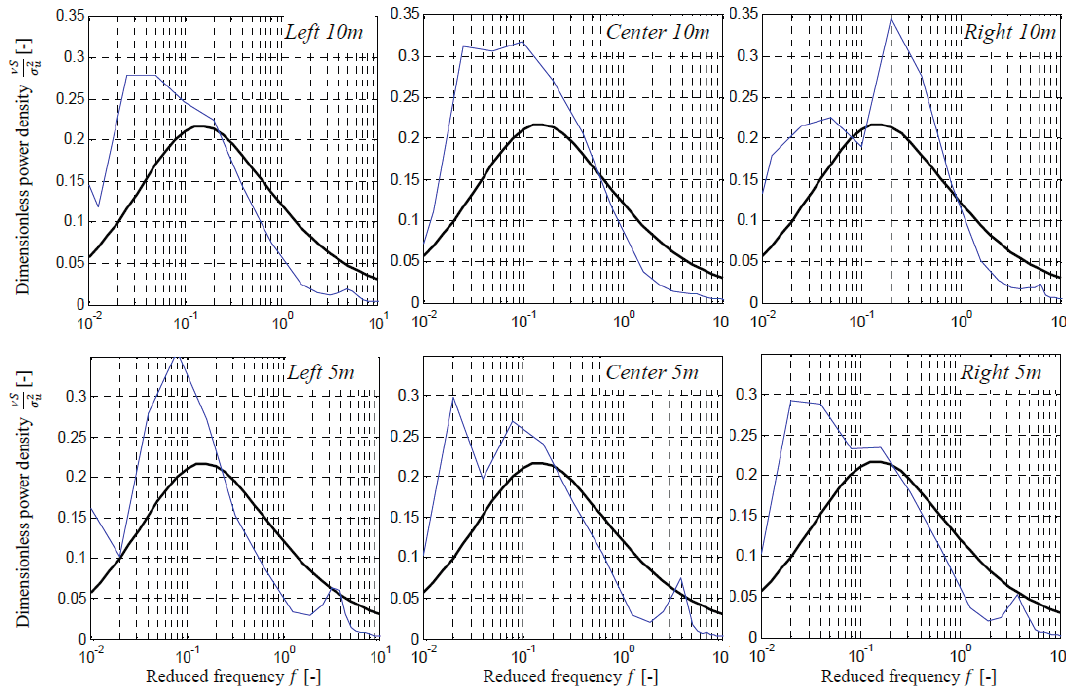
Figure 9. Power Density Spectra of streamwise component. Blue: LES results. Black line: Eurocode.